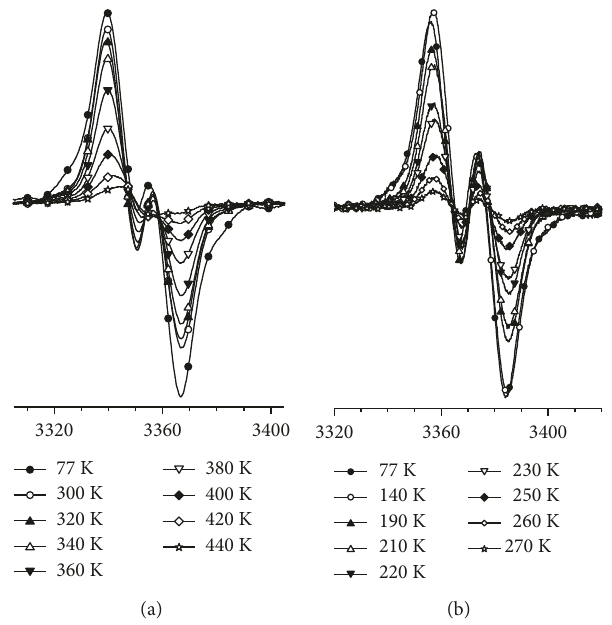
Figure 1: EPR spectra of the free radicals induced by UV irra- diation of silk fibroin annealed at various temperatures. Fibroin in (a) dry and (b) hydrated forms in 50% glycerol solution. All spectra were taken at 77K.